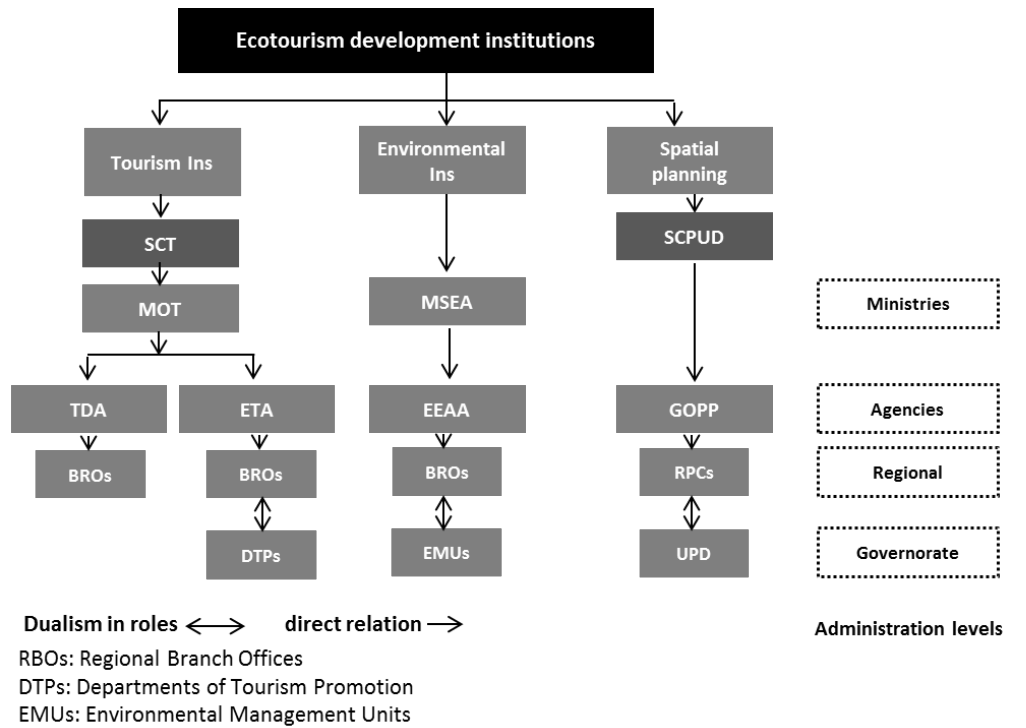
Figure 1. Ecotourism development institutions in Egypt. Source: The author.